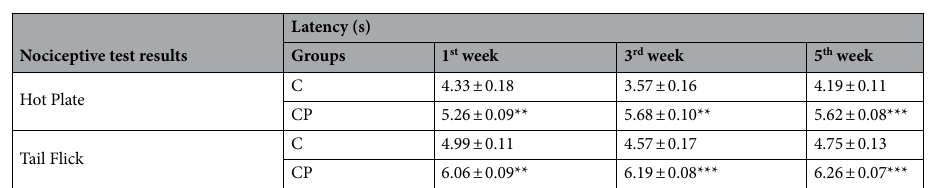
Table 1. Results of the nociceptive tests recorded as latency (s) of a reaction given in response to thermal painful stimuli during the 5-week period of chemical neuropathy induction. The data were represented as mean ± standard error of mean. Differences in between variances were compared by One-way ANOVA test with Tukey’s test applied as a post-hoc test. P -values equal or less than 0.05 were considered as statistically significant (* p < 0.05, ** p < 0.01, *** p < 0.001). The degree of significance was symbolized with asterisks (*) for the comparisons to that of control group